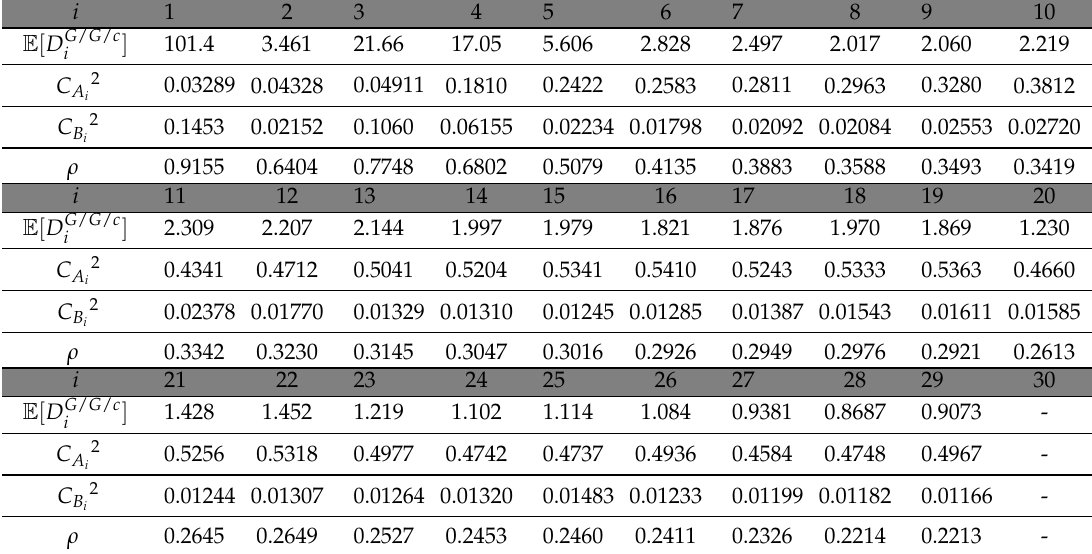
Table 3. Aircraft arrival delay and parameters of G / G / c model for airspace capacity c = 2 and arrival rate = 30 aircraft per